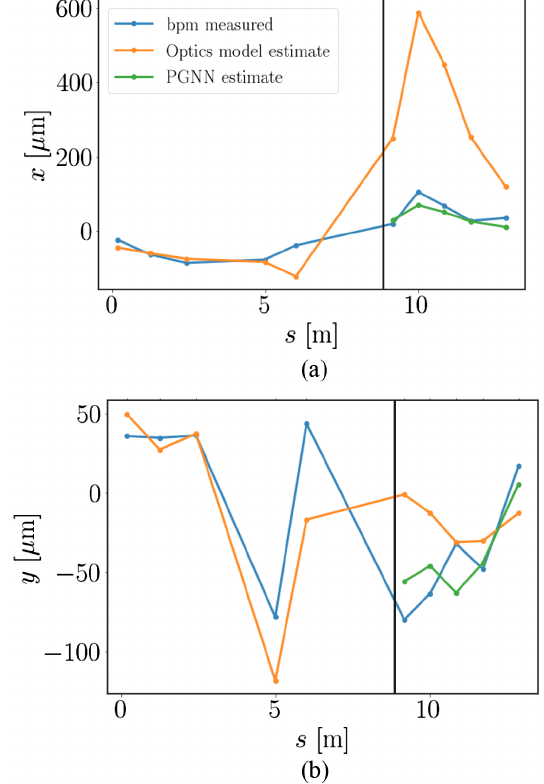
FIG. 12. A comparison of the optics model beam trajectory prediction (orange) and the PGNN prediction (green) with the measured high-charge BPM data (blue), shown for the horizontal (a) and vertical (b) planes. The start of the common line is denoted by a vertical black